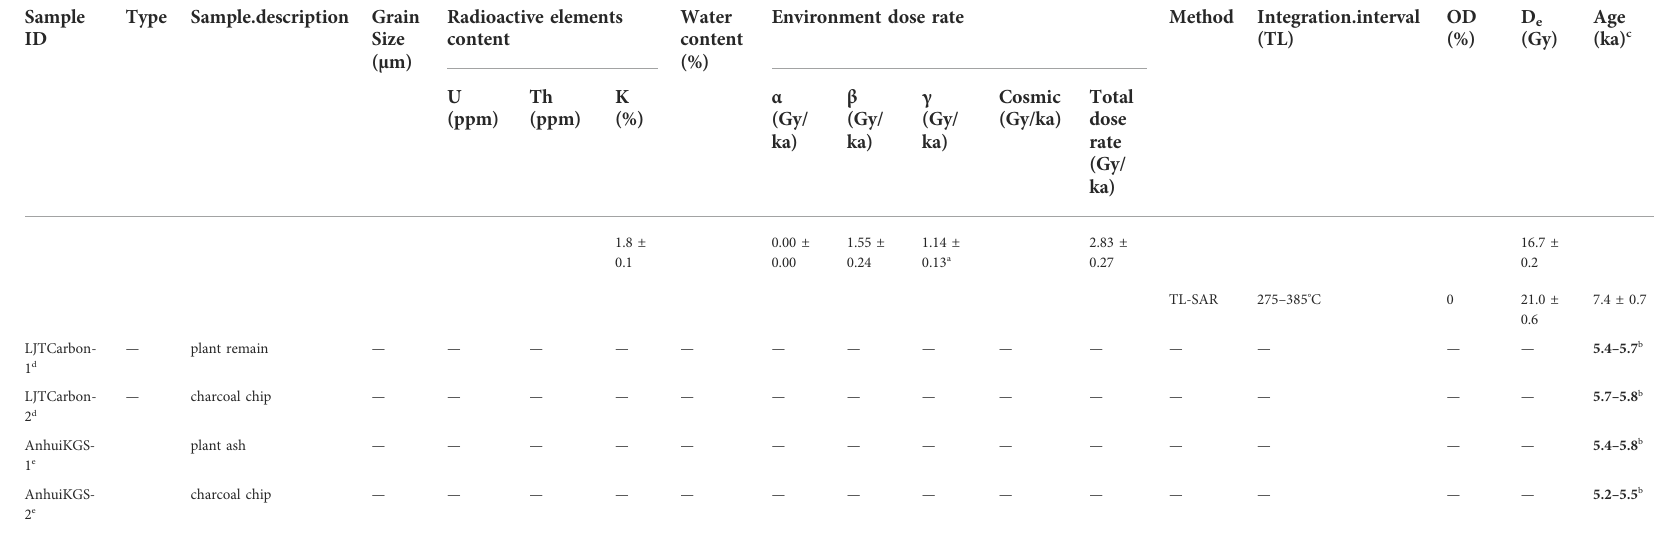
TABLE 1 ( Continued ) Summary of sample description, radioactive element content, dose rate, OSL, TL and 14 C